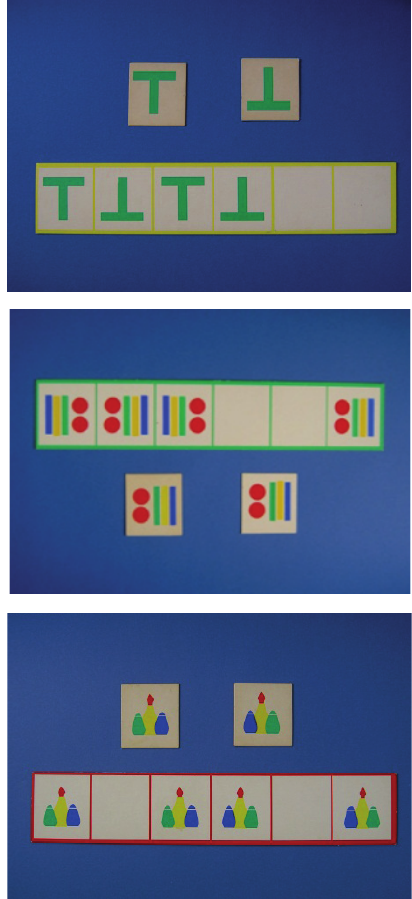
98Task 2b contains an AB pattern of green T-shapes. Here the same colour has been used throughout but the orientation of the T alternates. Thus all the loose cards are identical and the pattern emerges by changing the spatial orientation of the loose cards. The structure of the strip is ABAB_ _.